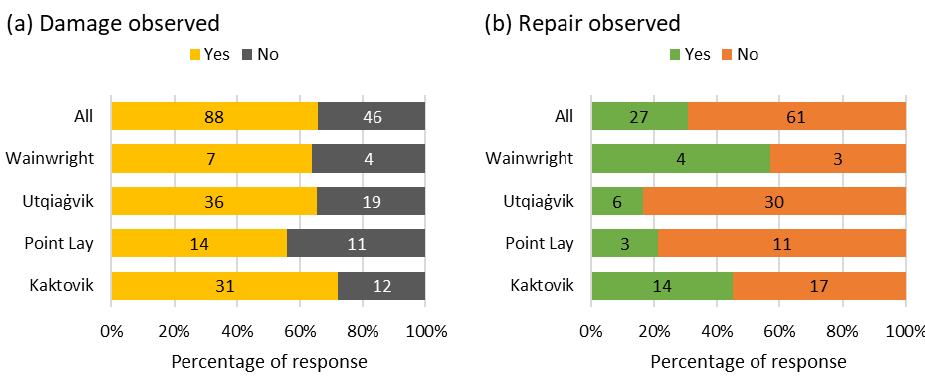
Figure 8. Figure 8. Observations of ( a ) damages and ( b ) repairs to residential houses caused by permafrost permafrost thawing.